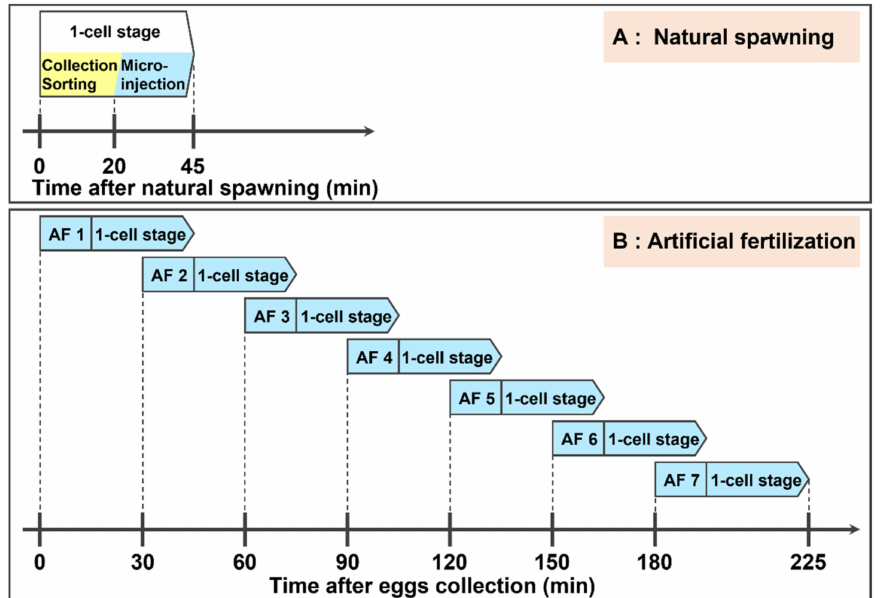
Figure 7. Schematic illustration of the available time of embryos from ( A ) natural spawning and ( B ) artificial fertilization for microinjection treatment in kawakawa Euthynnus affinis . In natural spawning ( A ), it is necessary to collect fertilized eggs which are spread in the land-tank or sea cages, and to sort out the eggs just after fertilization (one-cell stage) from the mixture of fertilized eggs of various developmental stages since multiple females spawn on the same day. Therefore, the microinjection treatment process remained only about 20 min out of the 45 min one-cell stage, excluding the time required for egg collection and sorting. On the other hand, when using embryos from artificial fertilization ( B ), it is feasible to provide many embryos for microinjection treatment by repeating artificial fertilization at least seven times (AF1 to AF7) every 30 min because we could preserve ovulated eggs until 3 h after collection with high developmental capacity.